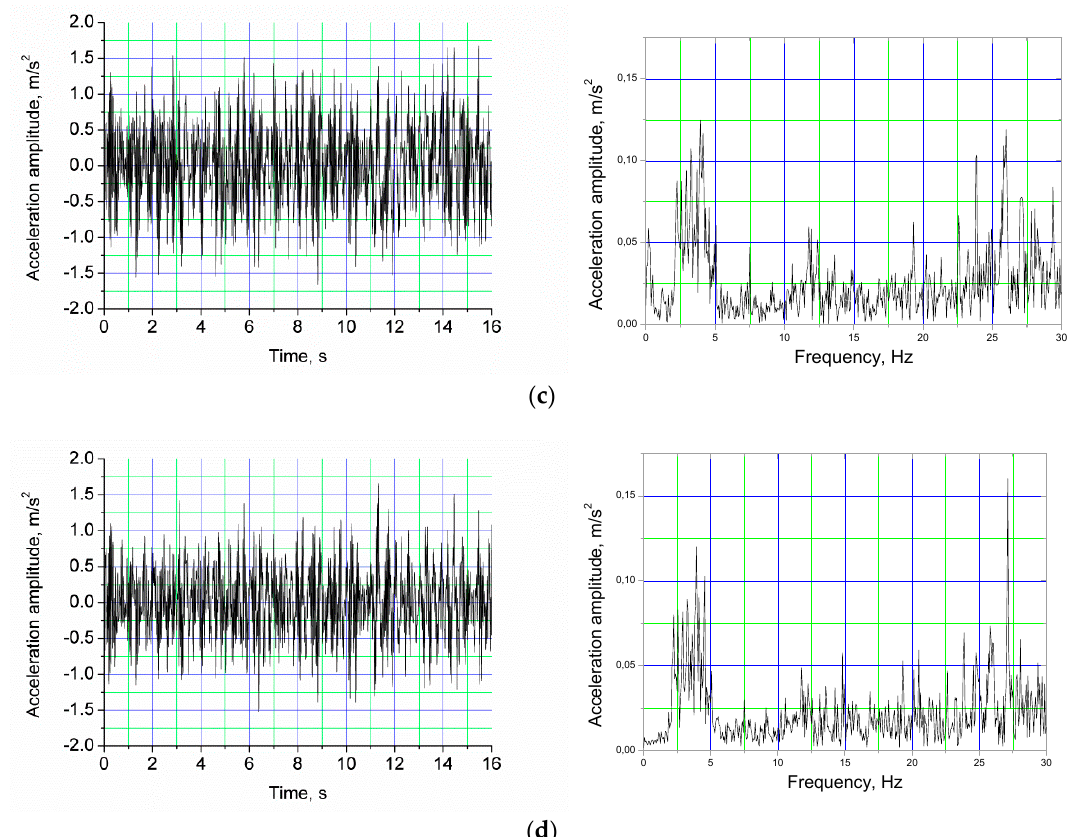
Figure 3. Vertical vibrations and their spectral density of beams 1 ( a , c ) and 2 ( b , d ) of the road overlay, ( a , b ) during the locomotive movement; ( c , d ) during the freight train movement.